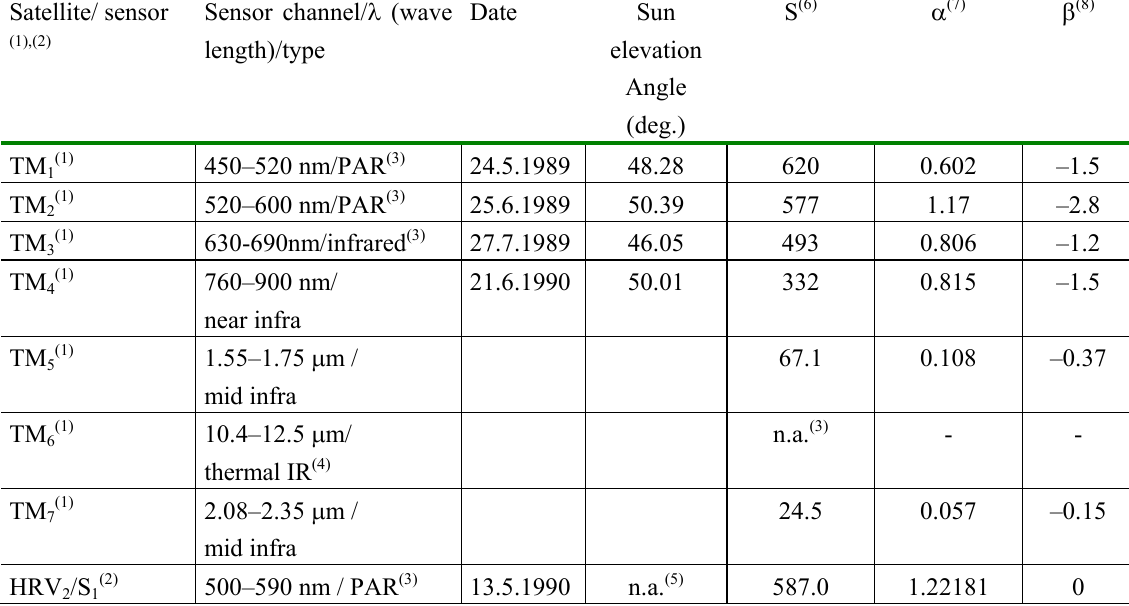
Table 11. The optical calibration parameters of Landsat and SPOT — satellites [57]. Satellite/